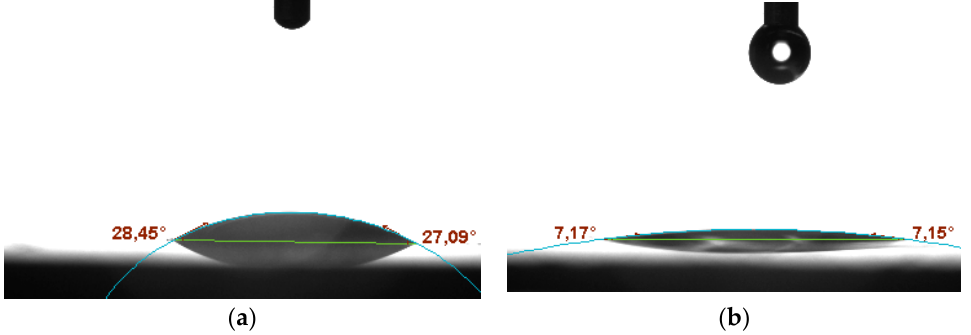
Figure 3. Contact angle microscope pictures of ( a ) anhydrous RuO 2 , ( b ) hydrous RuO 2 .